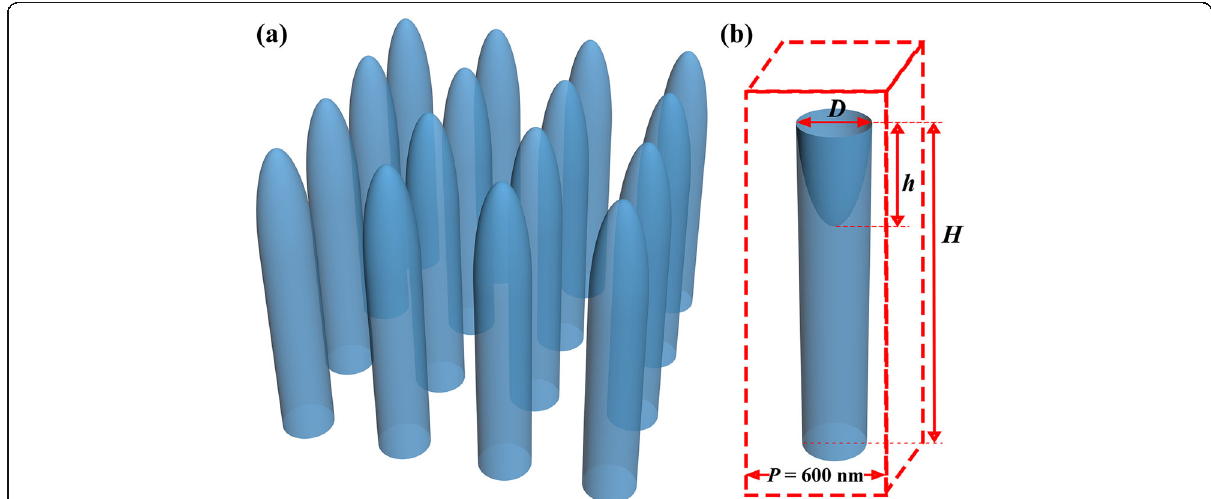
Fig. 1 a Schematic of a hemiellipsoid-modified NW array, and b a unit of an inverted hemiellipsoid-modified NW array for optical simulations. The structural parameters investigated in this study are the nanowire diameter ( D ), total height ( H ), and modification height ( h ) as